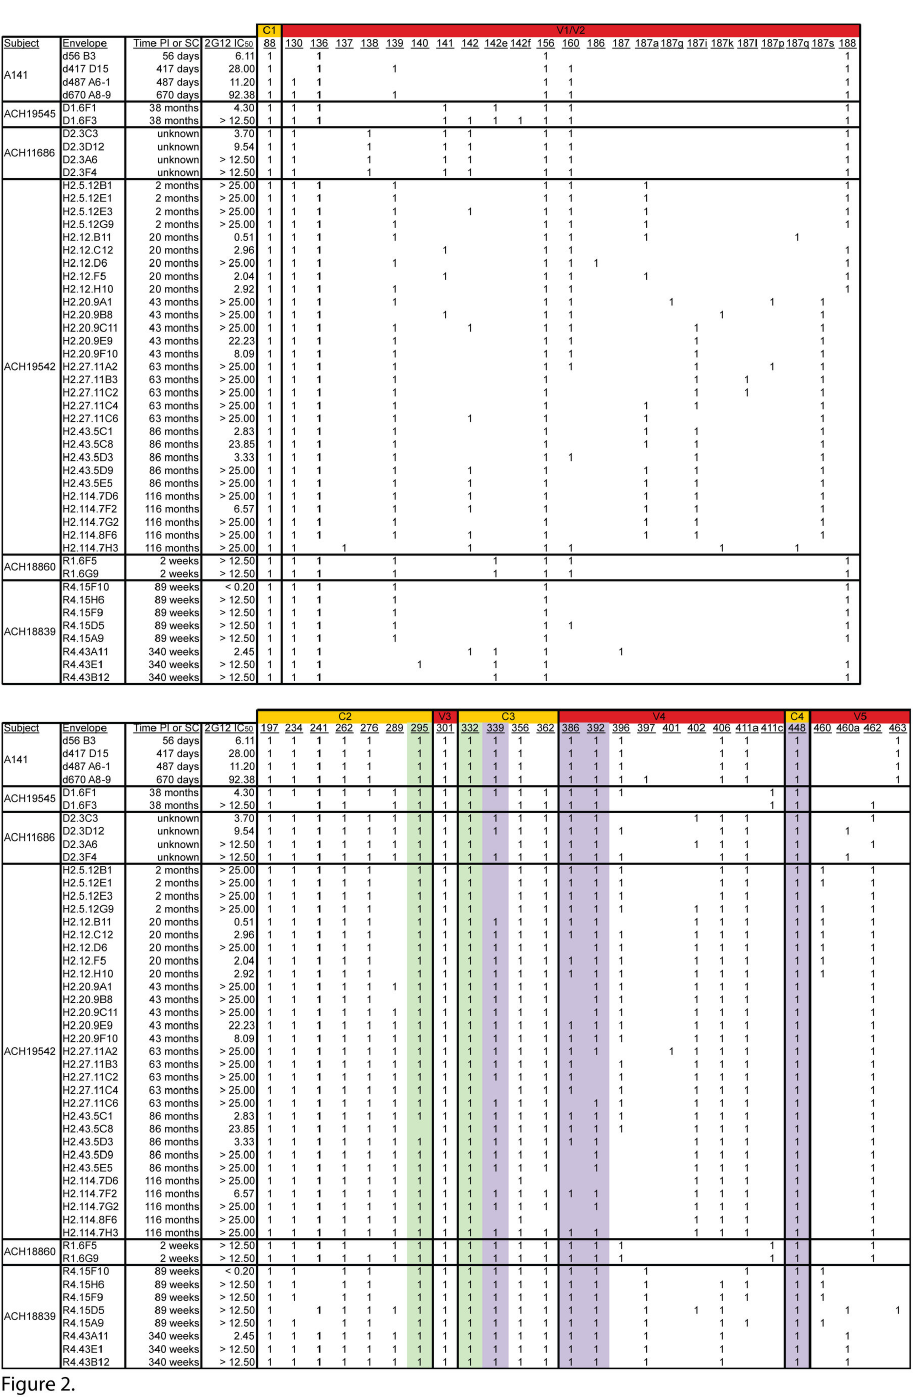
(µg/mL) and the time post infection 50 50